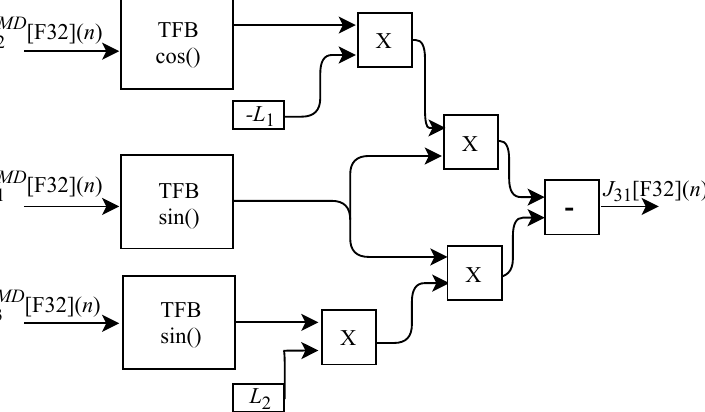
Figure 19. Proposed circuit to calculate the Jacobian matrix J 31 [ F 32 ]( n ) (Equation (31))—JM.